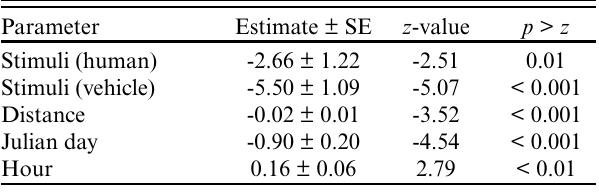
Table 3 . Estimates of maximum-likelihood parameters and significant deviation from 0 for the top model best describing response (1 = Piping Plover [ Charadrius melodus ] responded, 0 = Piping Plover did not respond) to natural stimuli using logistic regression. Categorical variables for stimuli are relative to the parameter estimate for